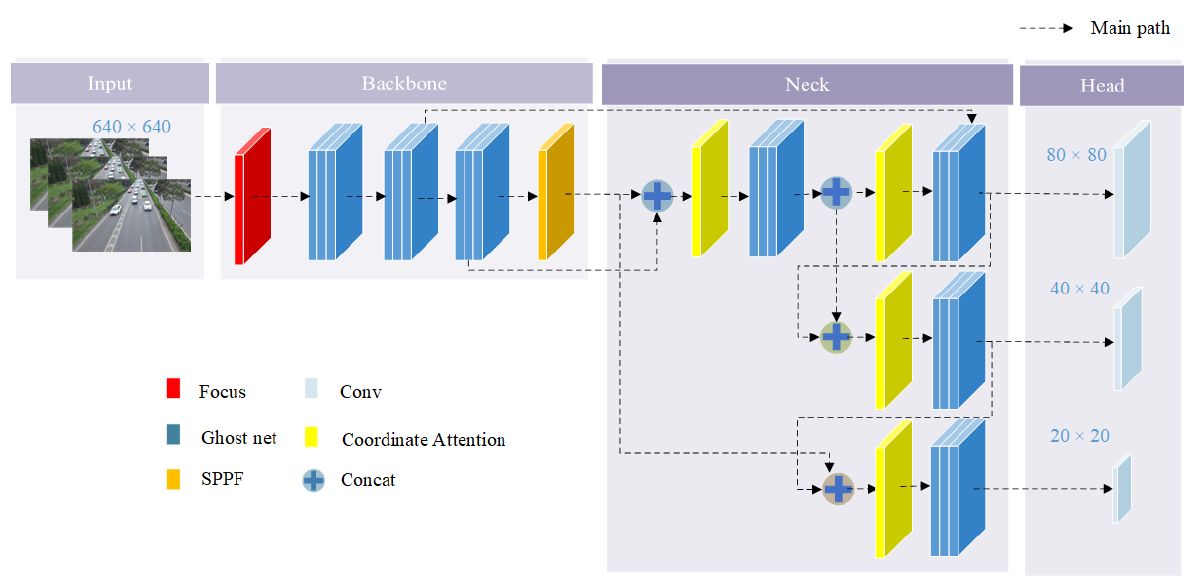
Figure 6. YOLOv5_N network structure.